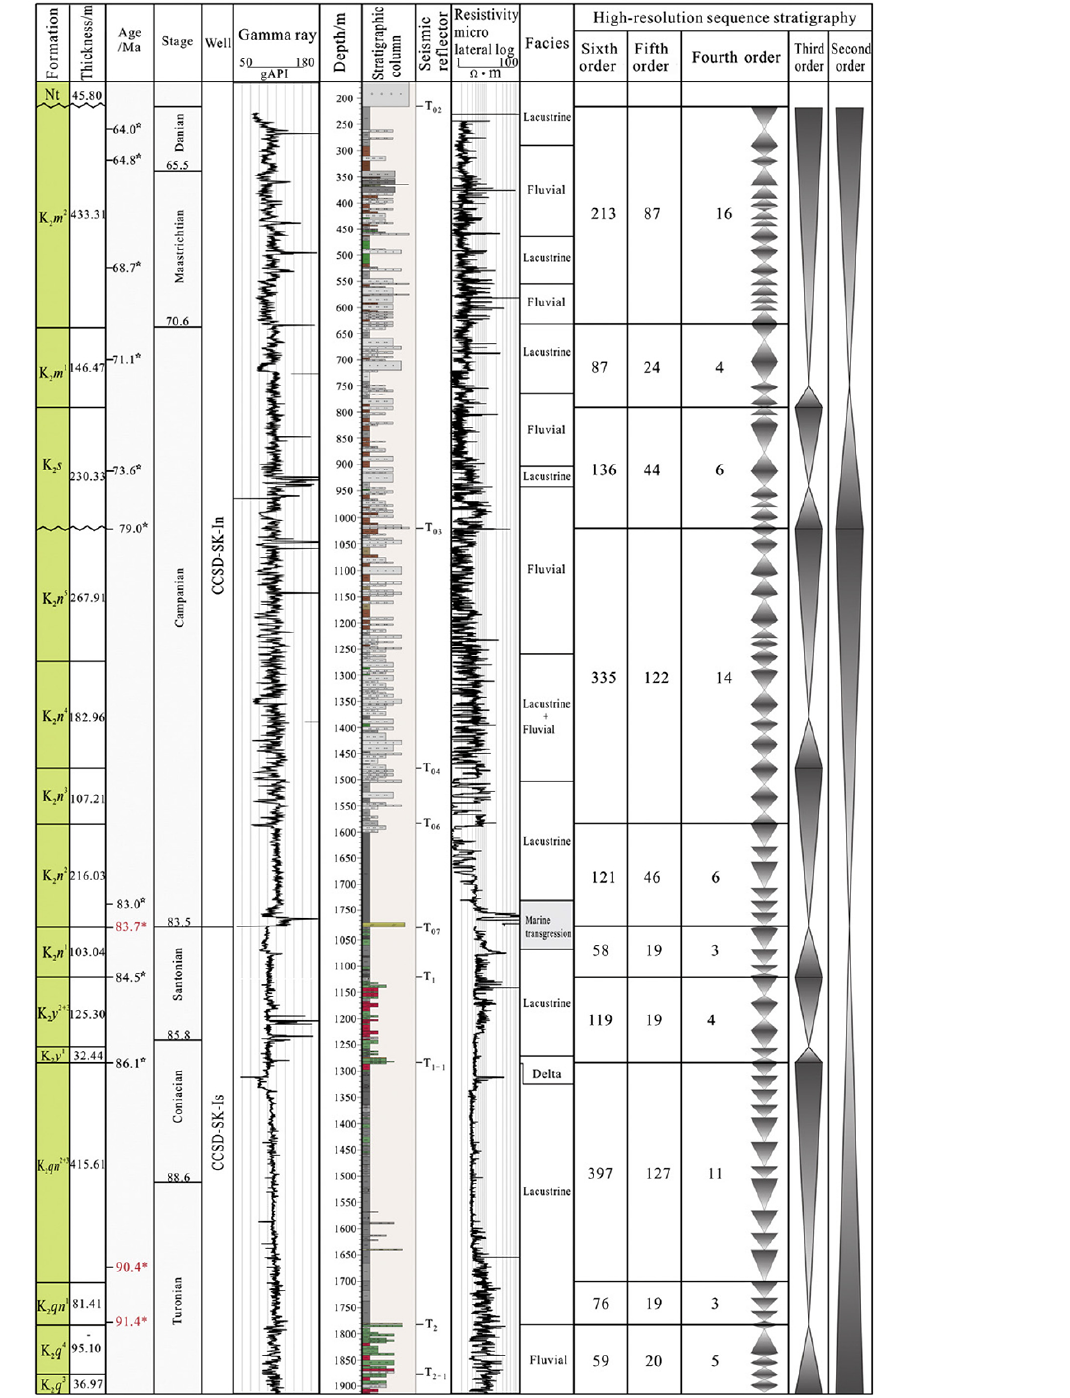
Figure 19. High-resolution sequence stratigraphy of Upper Cretaceous in the Songliao Basin. The figure on the right side of each segment is the number of cycles in each member or formation. Modified from Gao et al. (2009) (Wang et al.,